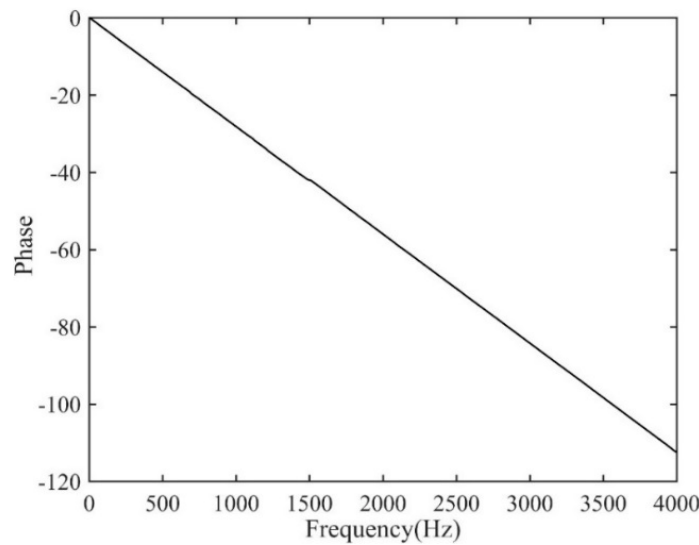
Figure 15. The new FRF between the signals measured at A2&A3.